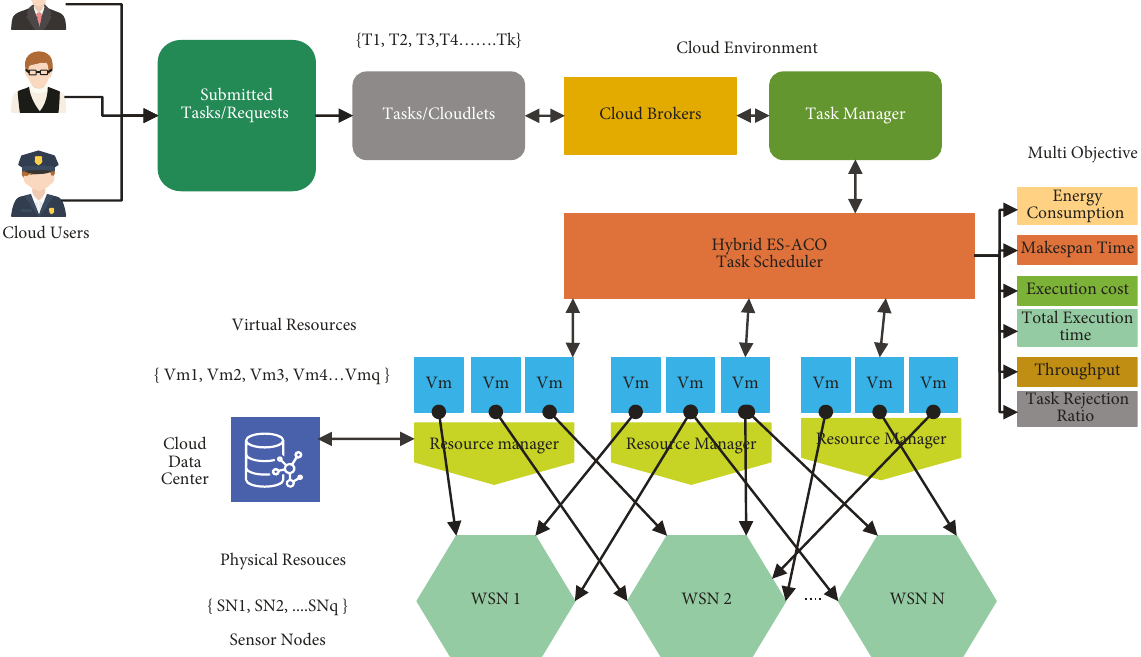
Figure 2: Proposed infrastructure model for task scheduling in sensor cloud